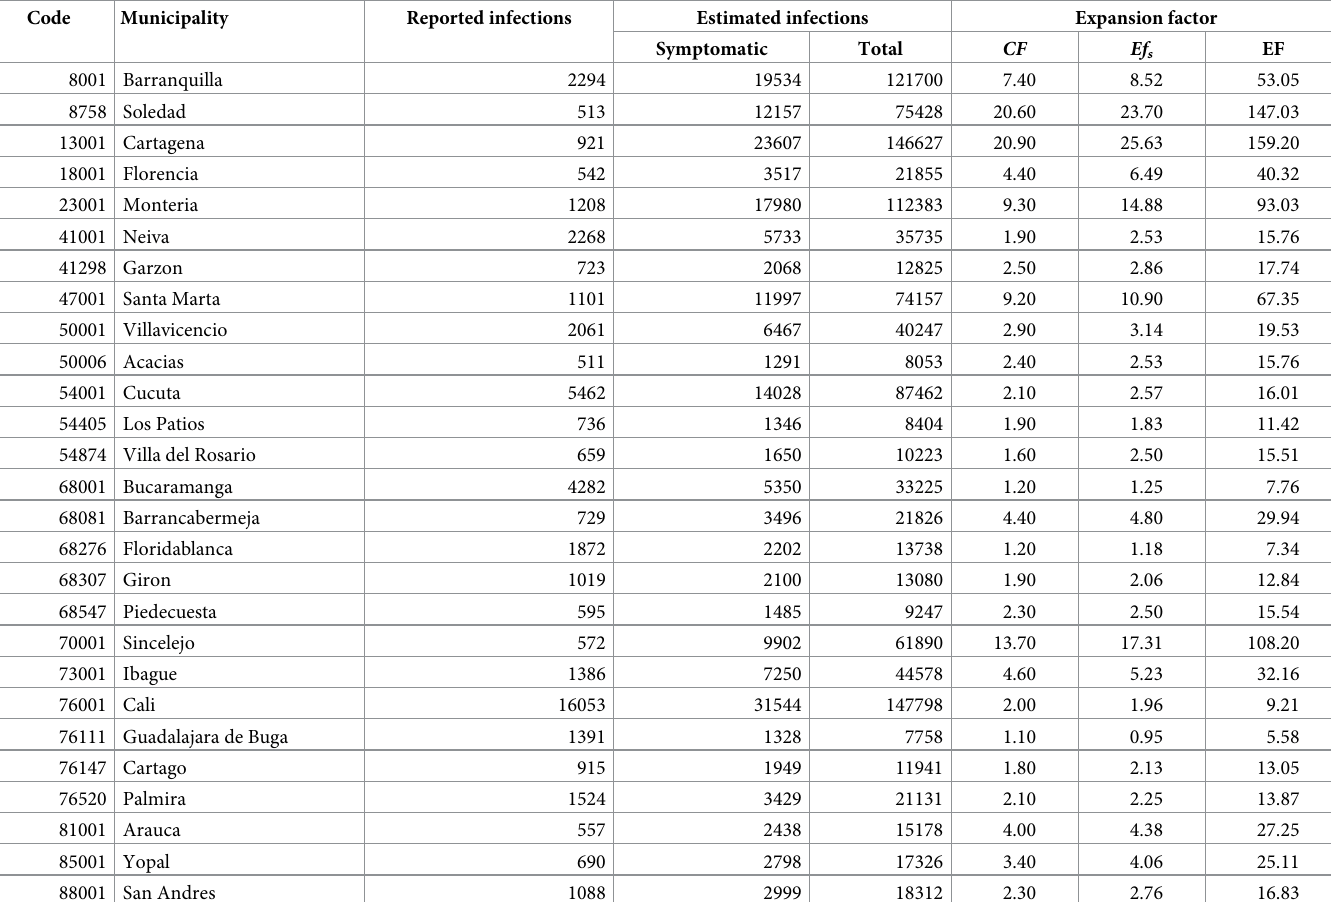
Table 4. Comparison between the number of reported infections and estimated